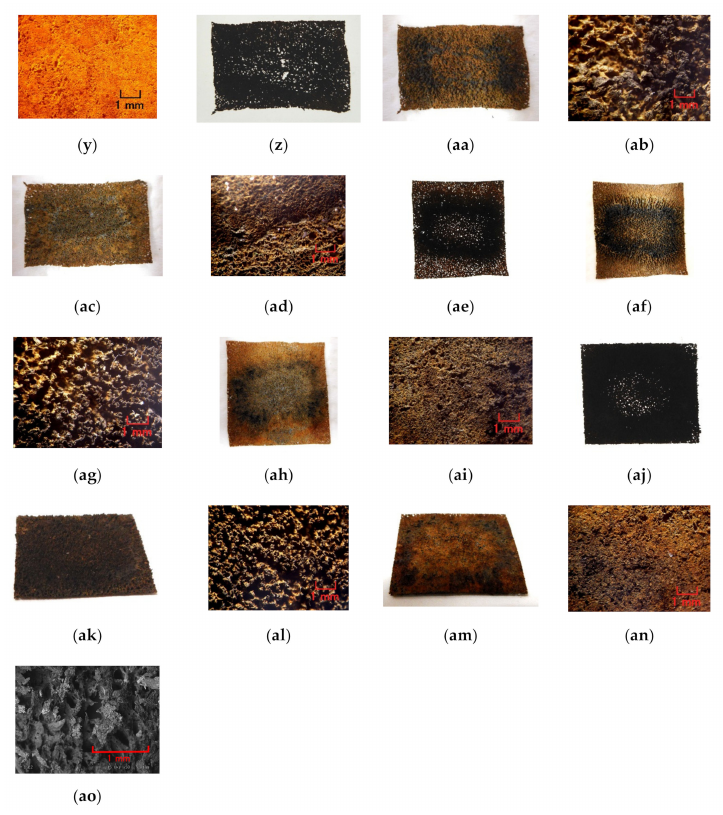
Figure 17. Images of electrolytically polymerized rubber: ( a – e ) 0.75 g MF, 0.5 g TiO 2 , 3 g S-500, 3 g